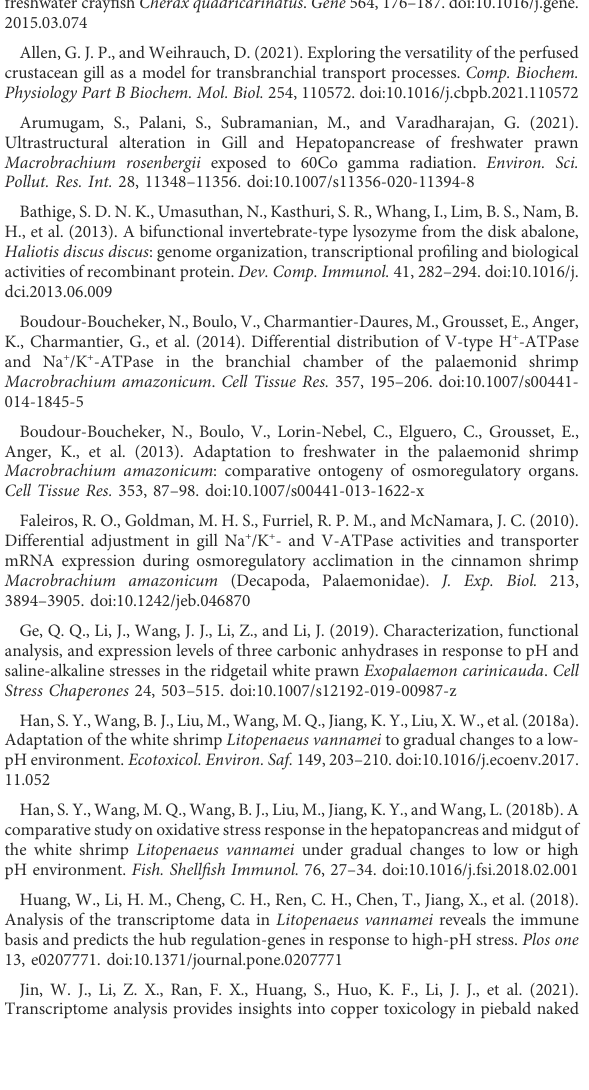
SUPPLEMENTARY FIGURE S1 GO enrichment of the DEGs in Cluster 0, 1 and 2. SUPPLEMENTARY FIGURE S2 The relative expression of ion transport related genes in gills. SUPPLEMENTARY FIGURE S3 GO and KEGG enrichments of DEGs in ion cell subcluster of pillar cells. SUPPLEMENTARY FIGURE S4 GO and KEGG enrichments of DEGs in immune cell subcluster of pillar